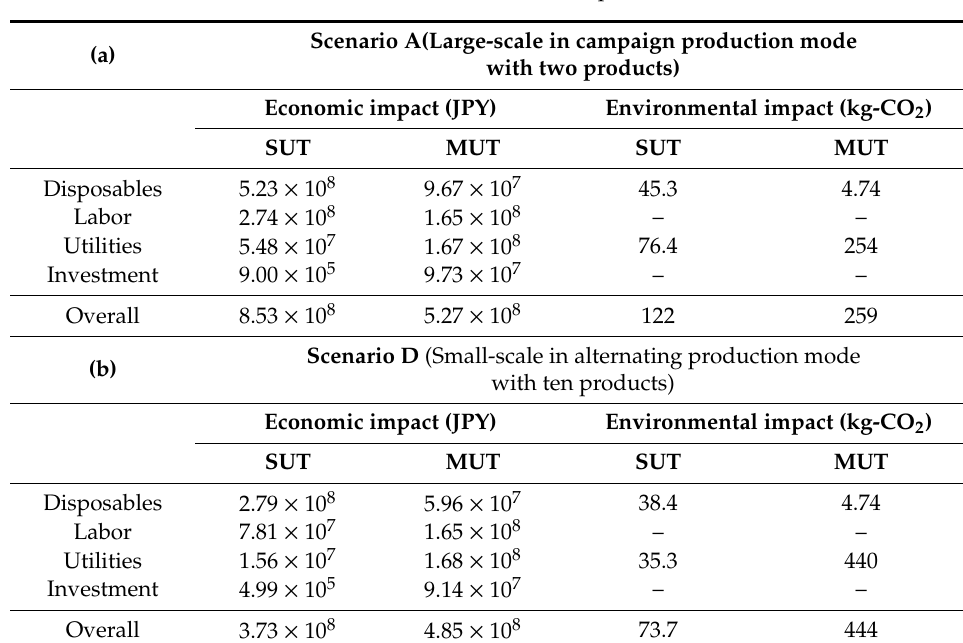
Table 6. Breakdown of economic and environmental impacts of Scenarios ( a ) A and ( b )